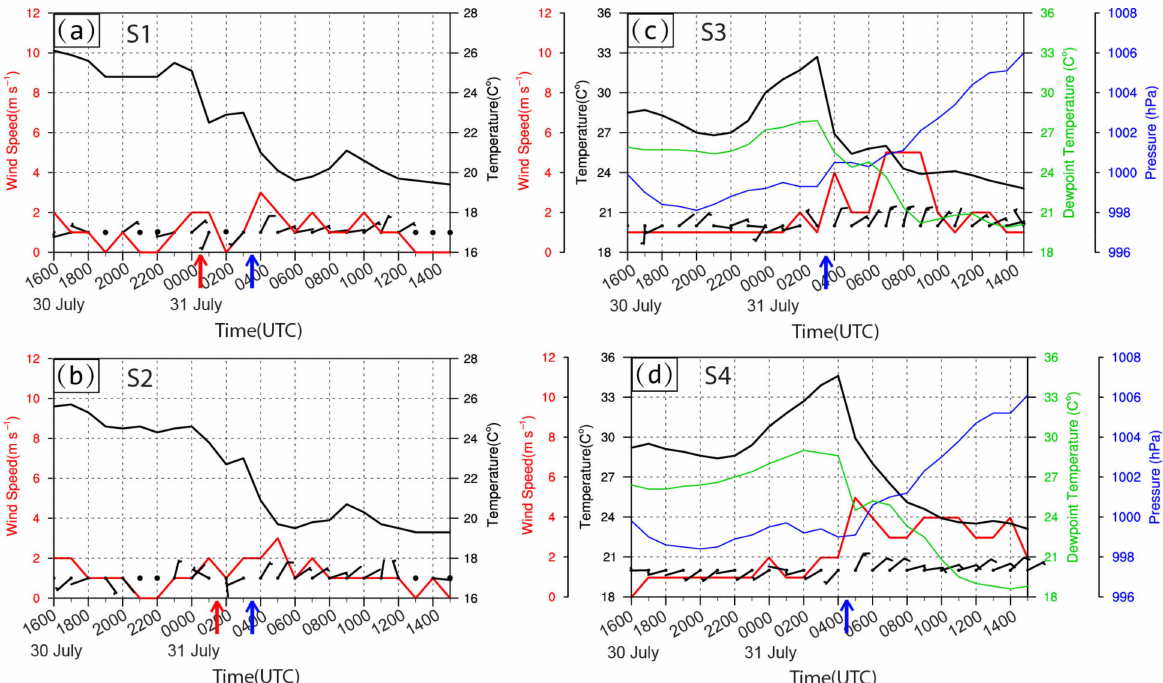
Figure 4. ( a – d ) Evolution of observed temperature (black lines, units: ◦ C), dewpoint temperature (green lines, units: ◦ C), pressure (blue line, units: hPa), and wind information (red lines show the wind speed, half and full wind barbs represent 2 and 4 m s − 1 , respectively) from 1600 UTC 30 July to 1500 UTC 31 July 2010 at ground-based automatic weather stations S1, S2, S3, and S4 (see the locations of S1, S2, and S3 in Figure 1a). The dewpoint temperature and pressure were absent because they were missing in S1 and S2 during this period. The missing winds are indicated as black dots. The red and blue arrows indicate the time of temperature drop and wind shift induced by the passage of the SBF and GF,